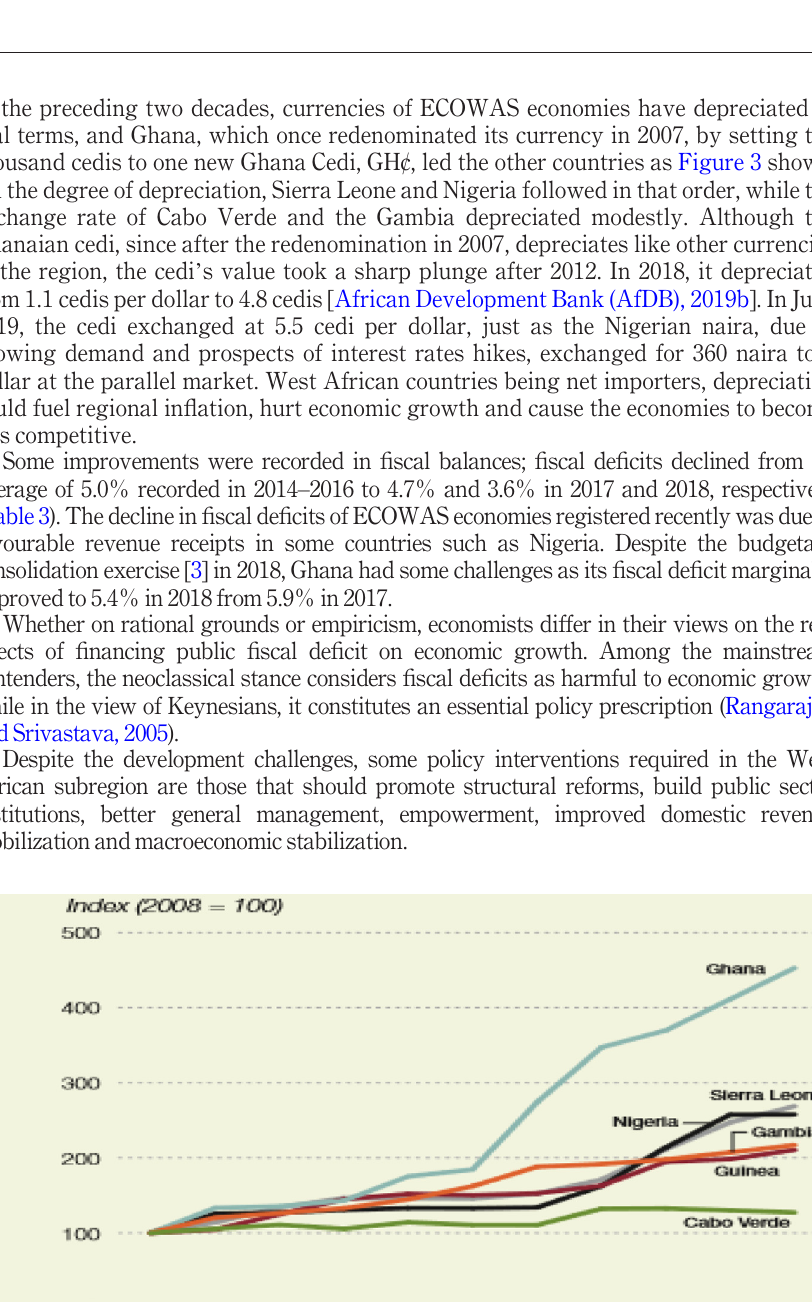
Figure 3. Real exchange rate indices in selected non-West African Economic and Monetary